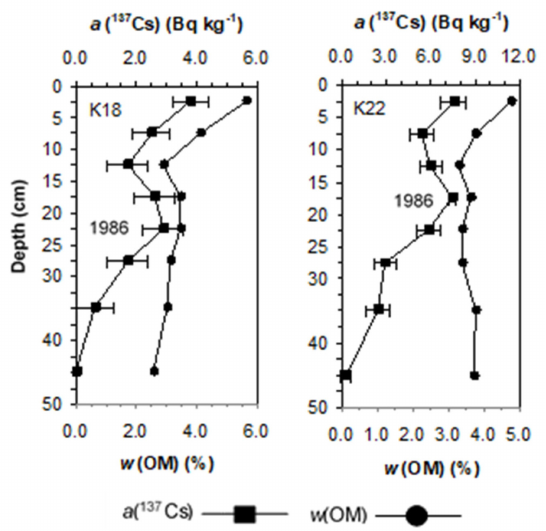
Figure 6. 137 Cs massic activity profiles reflecting subsequent 137 Cs input after 1986 and organic matter mass fraction profiles. Measurement uncertainties are expressed with k = 2 for normal distribution.